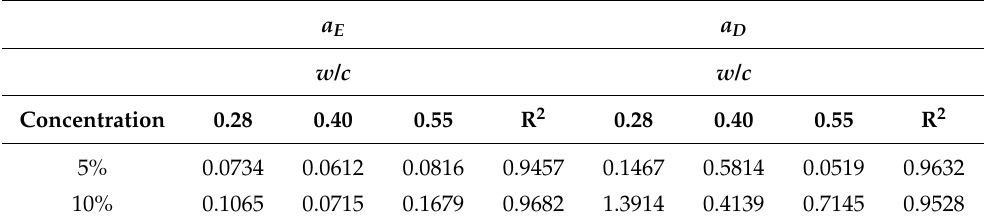
Table 5. Fitting parameters for maximum stress level 0.5 and minimum stress level 0.2. a E a